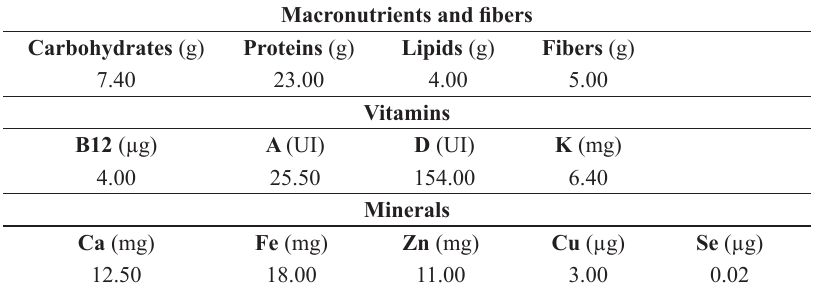
Nutritional composition of Presence Nestlé ® chow.